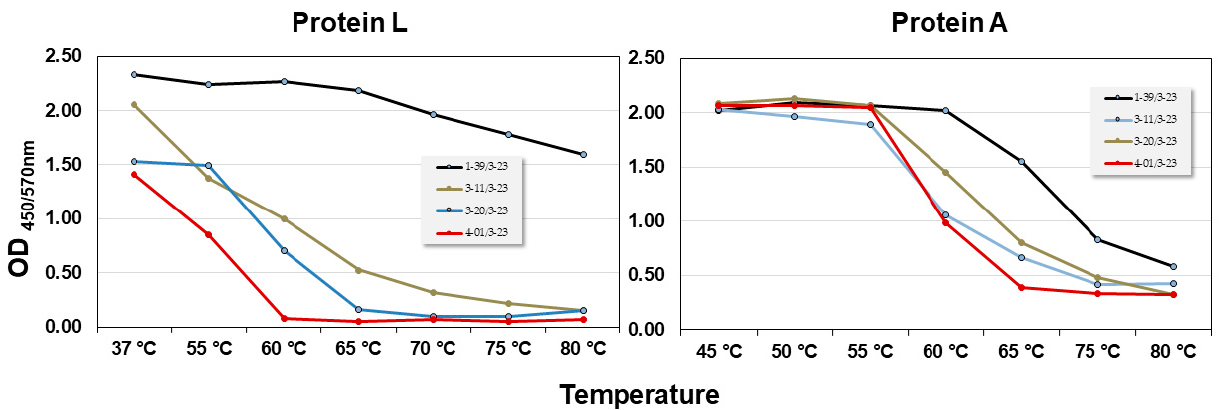
Figure 1. Comparison of the thermal stability profile of the VL scaffolds using Protein L and Protein A.